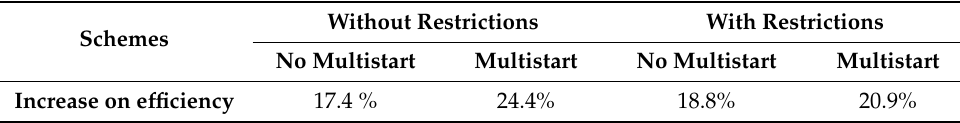
Table 1. Improvement in the methane produced by each MPC control scheme.